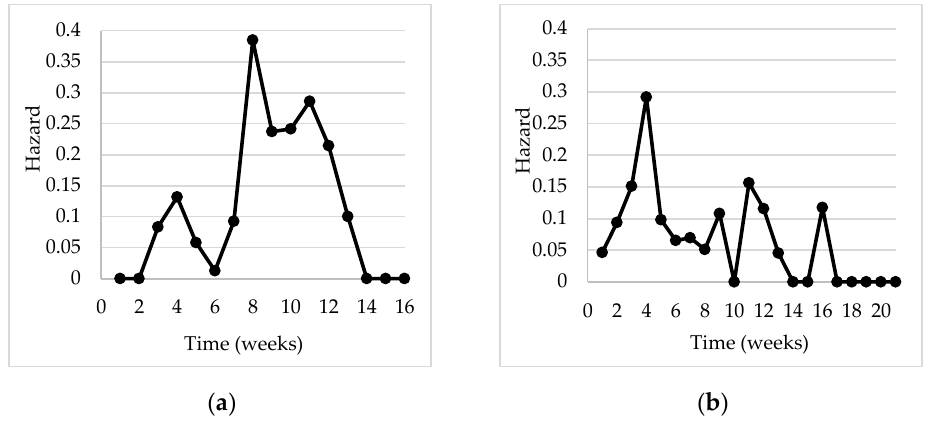
Figure 6. Kaplan–Meier estimator—probability of not reaching 20% decline ( a ) and increase ( b ) in values of the stock indices. Source: own elaboration, Statistica.